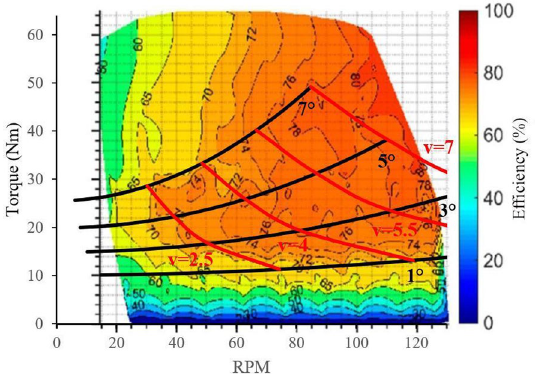
Fig. 17 Global efficiency as a function of the travel speed at con- stant gear ratio. Steady-state drive on a flat